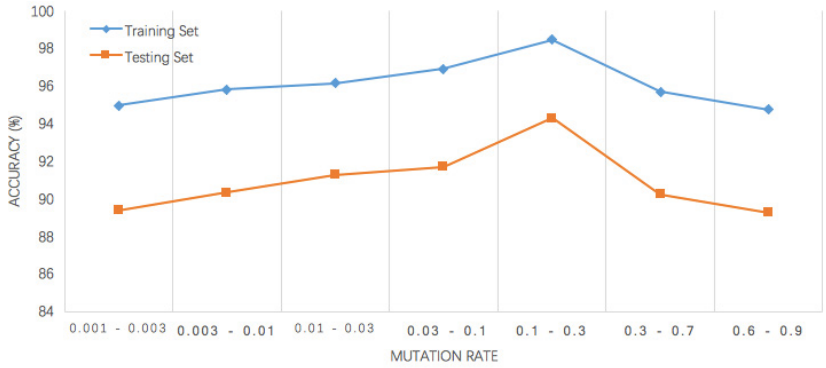
Figure 4. Accuracies of training set and testing set of ELM and G-ELM.